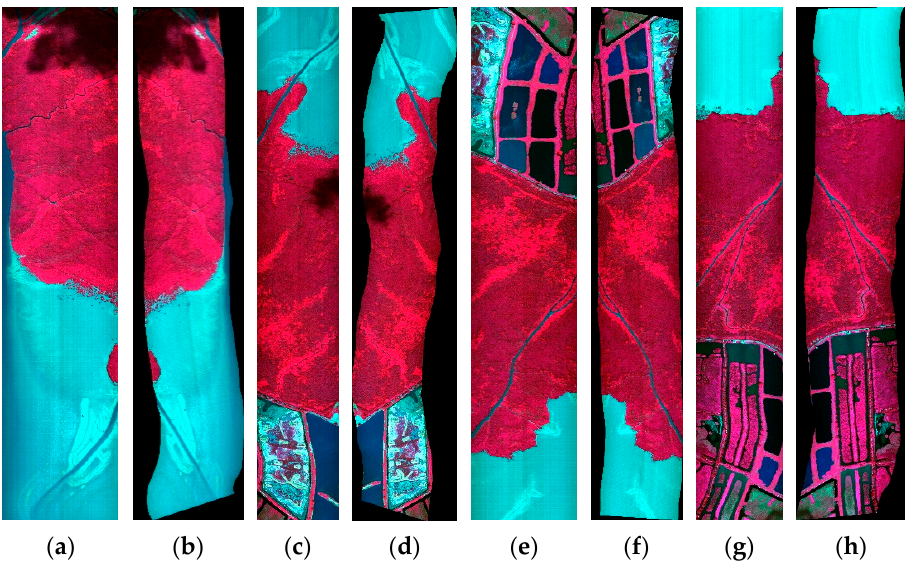
Figure 8. Four flight image strips ( a , c , e , g ) before and ( b , d , f , h ) after georeferencing shown in pseudo color with infrared, red, and green bands. Figure 8b,d,f,h show the results of rotating the georeferenced images clockwise by 239.61°, 65.07°, 241.74°, and 64.26°, respectively.